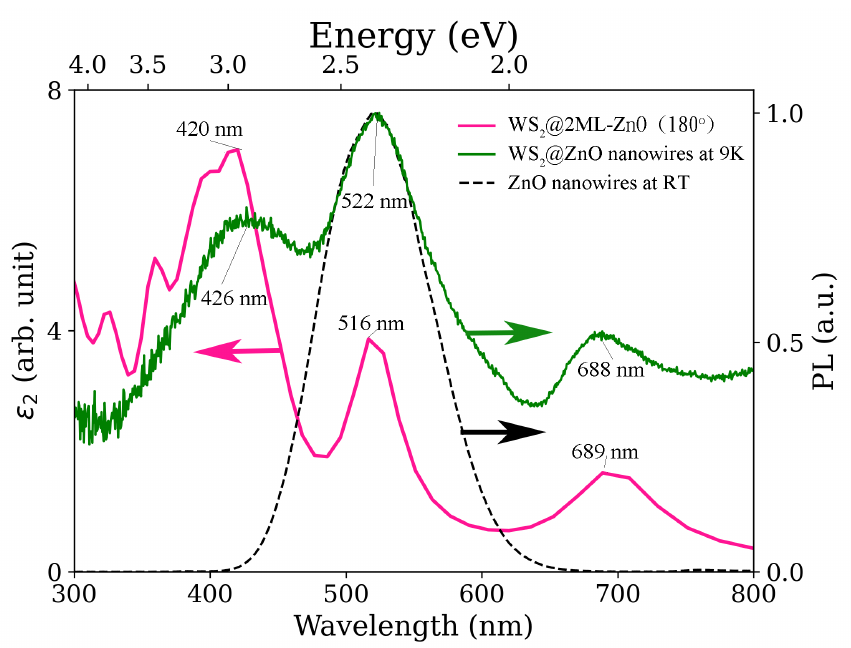
Figure 10. Comparison of the photoluminescence (PL) spectra measured for WS 2 @ZnO nanowire at 9 K using the fourth harmonic (266 nm, or 4.66 eV) of a Nd:YAG laser FQSS266 (CryLas GmbH) as an excitation source (green solid line) and calculated absorption spectra for WS 2 @ZnO heterostructure with the rotation angle of 180 ◦ (magenta line). The photoluminescence spectra were recorded using the Andor Shamrock B-303i spectrograph equipped with a CCD camera (Andor DU-401A-BV). Spectrum of ZnO nanowires measured at room temperature is drawn with black dotted line [22].